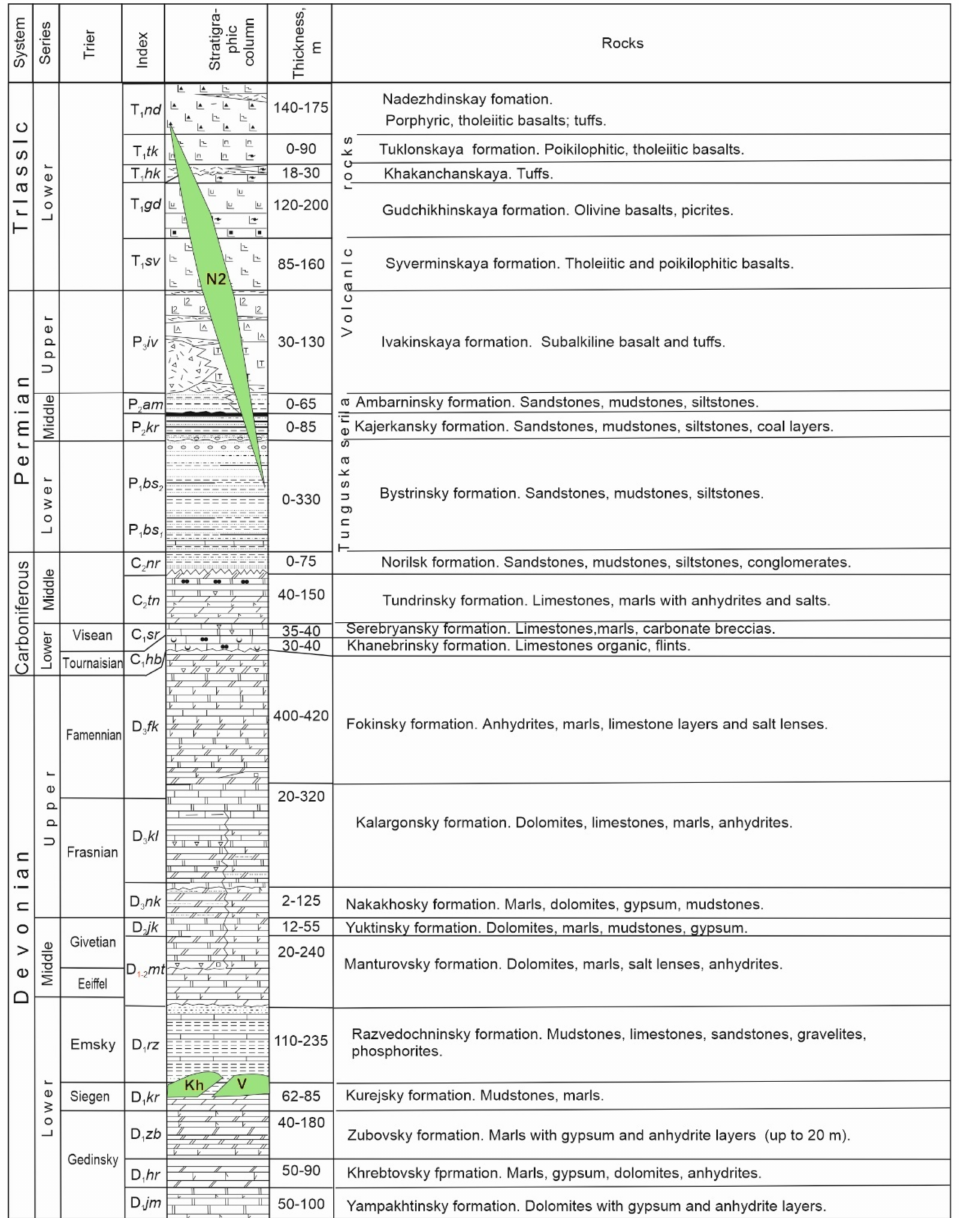
Figure 3. Positions of intrusions in the stratigraphic sequence of the Norilsk area. Intrusions: Kh, Kharaelakh; V, Pyasinsky- Vologochansky; and N2, Norilsk 2 (based on